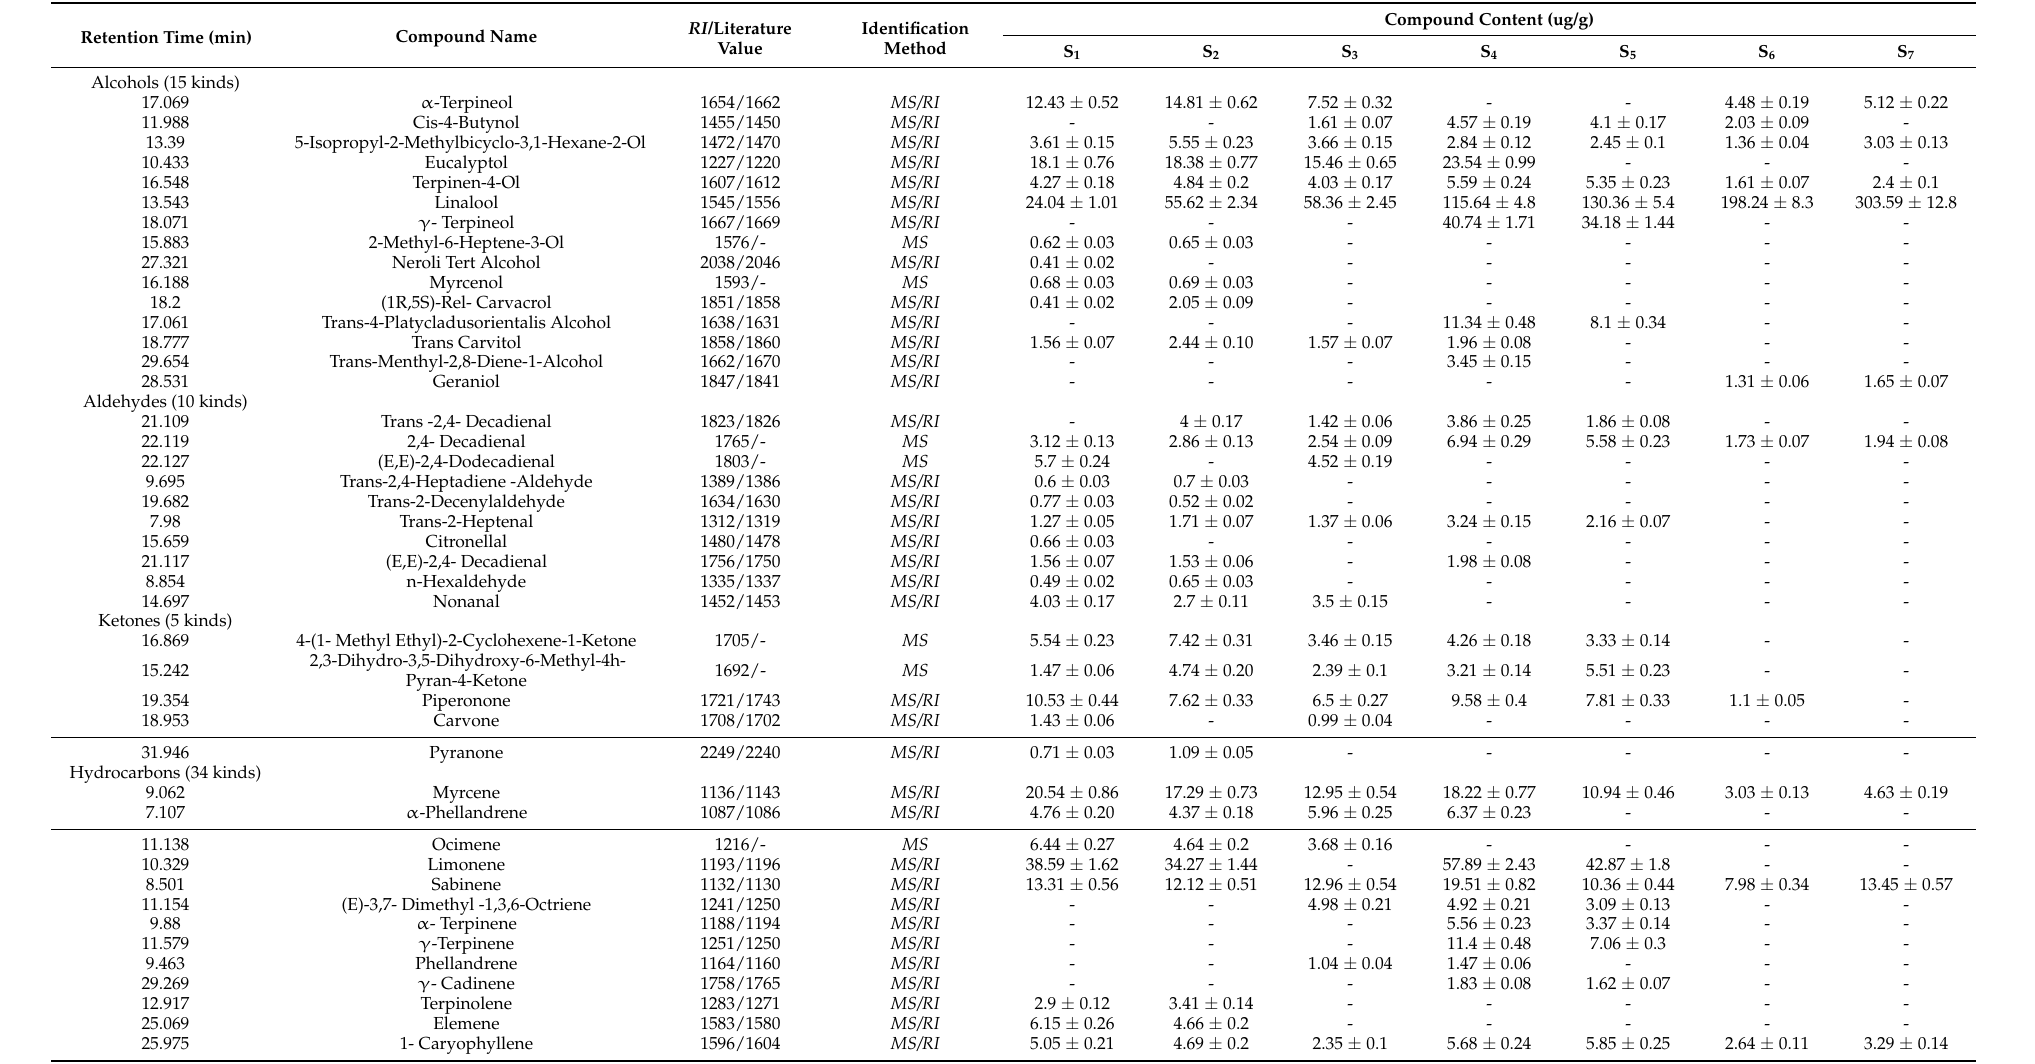
Table 1. Aroma components and content of different varieties of pepper